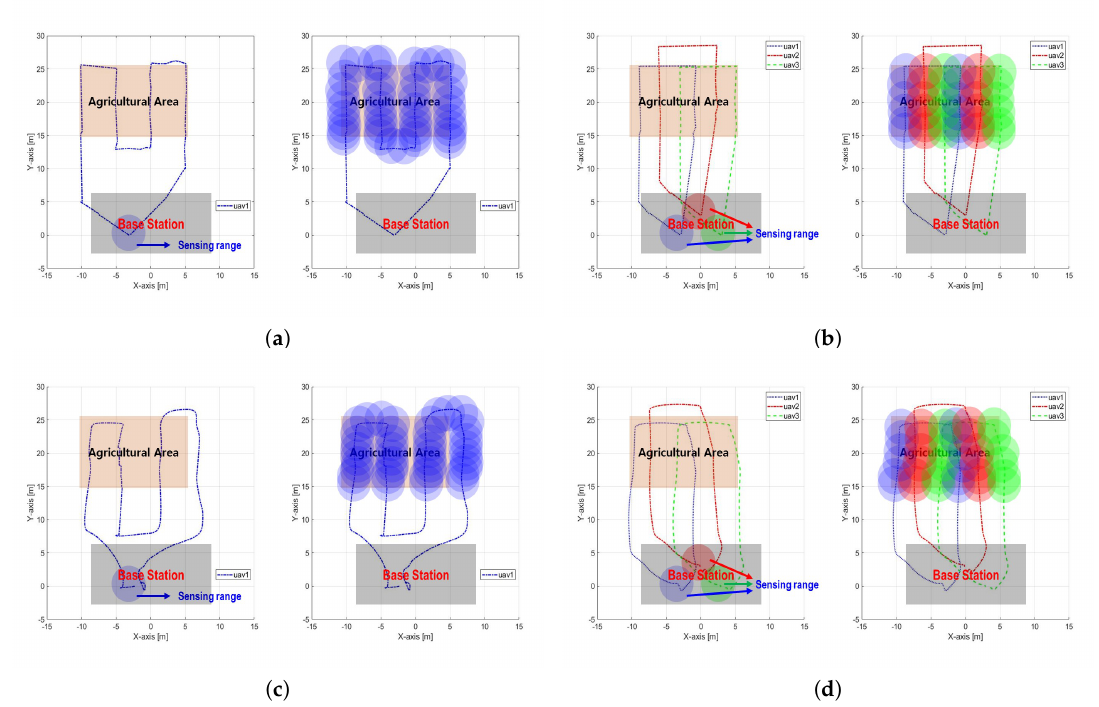
Figure 5. Experimental results of remote sensing for each case: Flight trajectory for one trial. ( a ) case of Auto-Single-UAV ( b ) case of Auto-Multi-UAV ( c ) case of Tele-Single-UAV ( d ) case of Tele-Multi-UAV